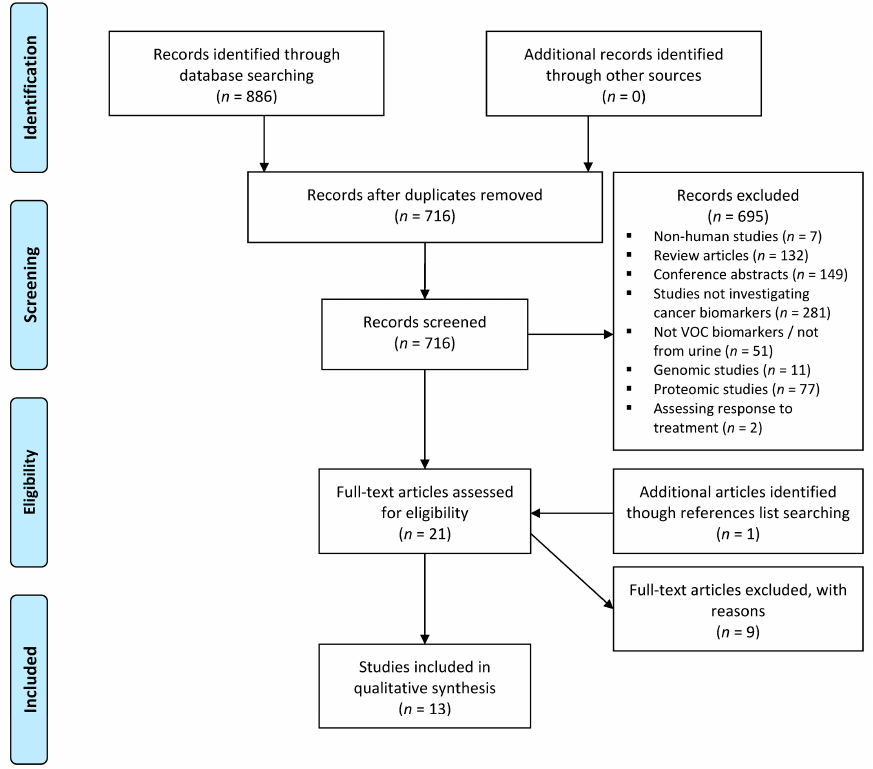
Figure 1. Preferred Reporting Items for Systematic Reviews and Meta-Analyses (PRISMA) flow diagram. VOC: volatile organic compound. The systematic literature search identified 886 studies, with 13 studies included after screening and assessment for eligibility.